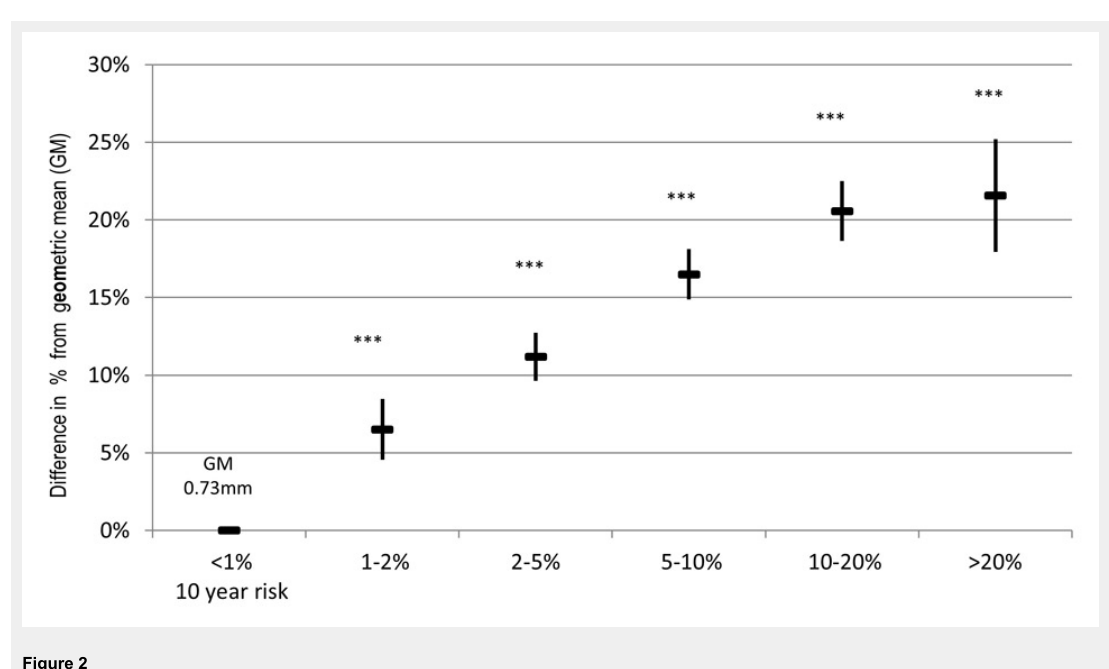
Association of AGLA-1 with aCIMT in SAPALDIA 3. ▬ Depicts estimated %difference of the geometric mean (GM), ▌ confidence interval of estimated %change. *** p-value <0.001, between risk and reference category, α adjusted for study area (random